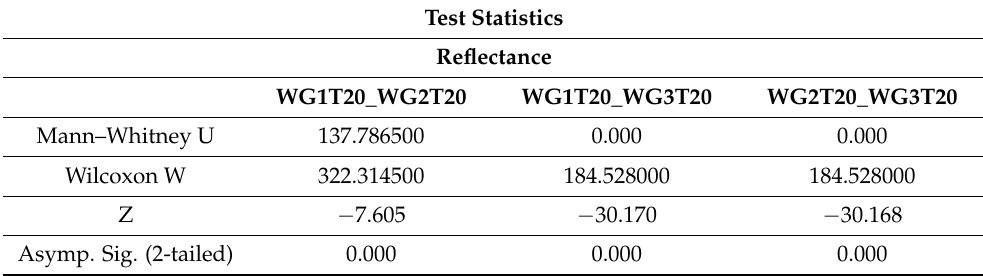
Table A10. Test statistics table of the Mann–Whitney U test for specular solar reflectance, according to the holding time of 20